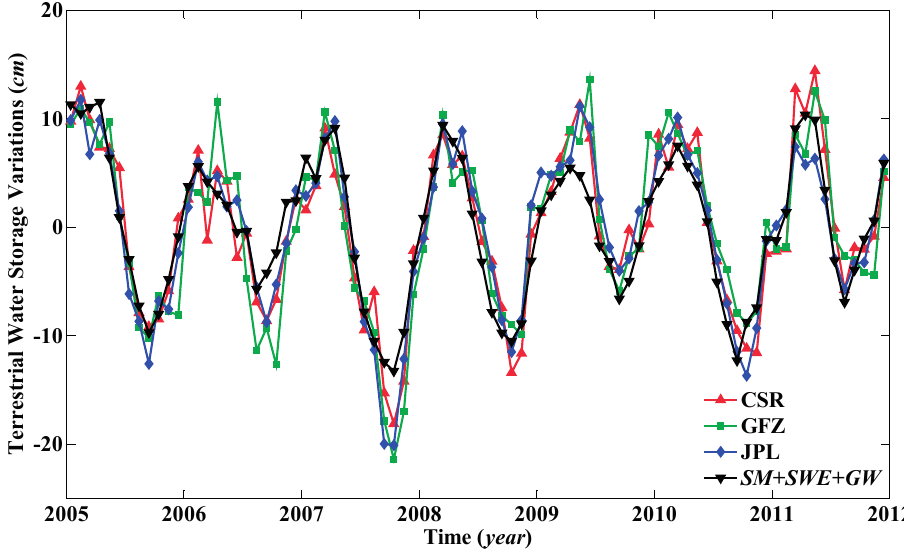
Figure 3. GRACE-derived terrestrial water storage (TWS) and TWS derived by combining GLDAS estimated soil moisture (SM) and snow water equivalent (SWE) with in-situ groundwater (GW)